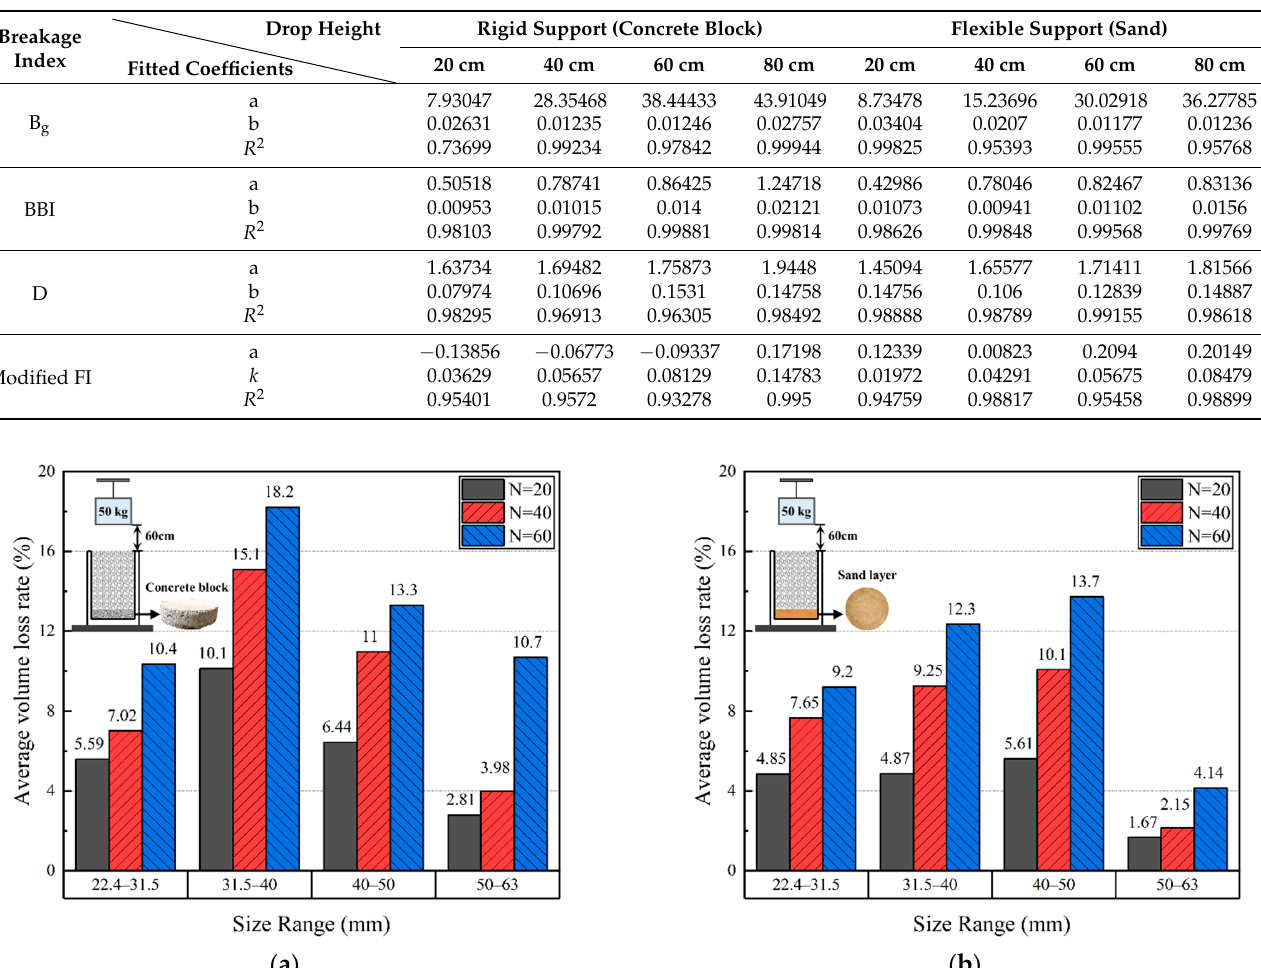
Table 4. The fitted coefficient values of Equations (7) and (9) for multiple-size ballasts under different combinations of under-ballast supports and drop heights.